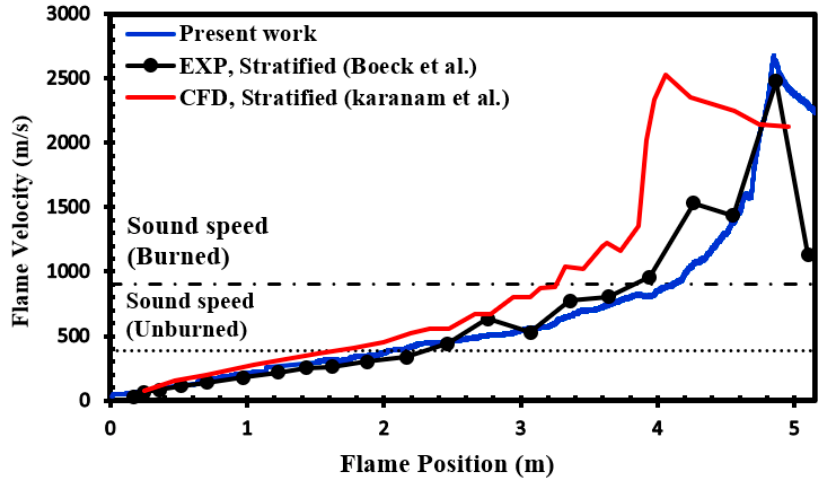
Figure 6. The flame velocity in the stratified H 2 –air mixture with 22.5% hydrogen concentration, along with the experimental results of Boeck et al. [64] and the numerical results of Karanam et al. [65]